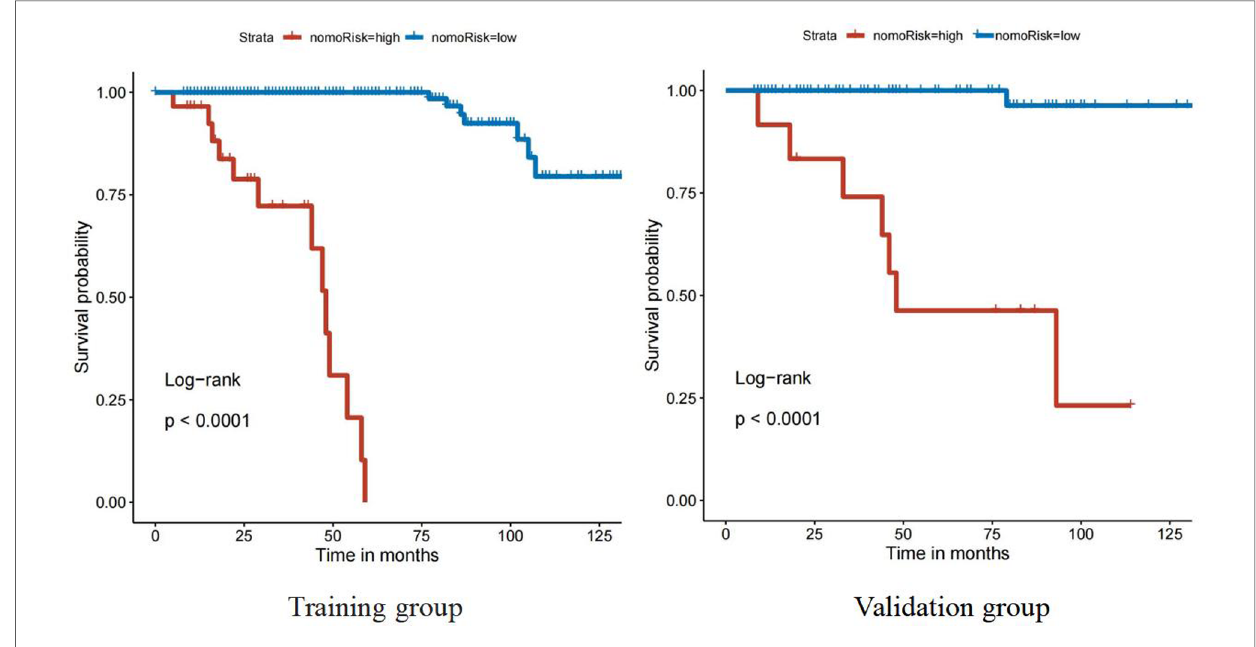
FIGURE 4 The Kaplan-Meier curves of training group and validation group.